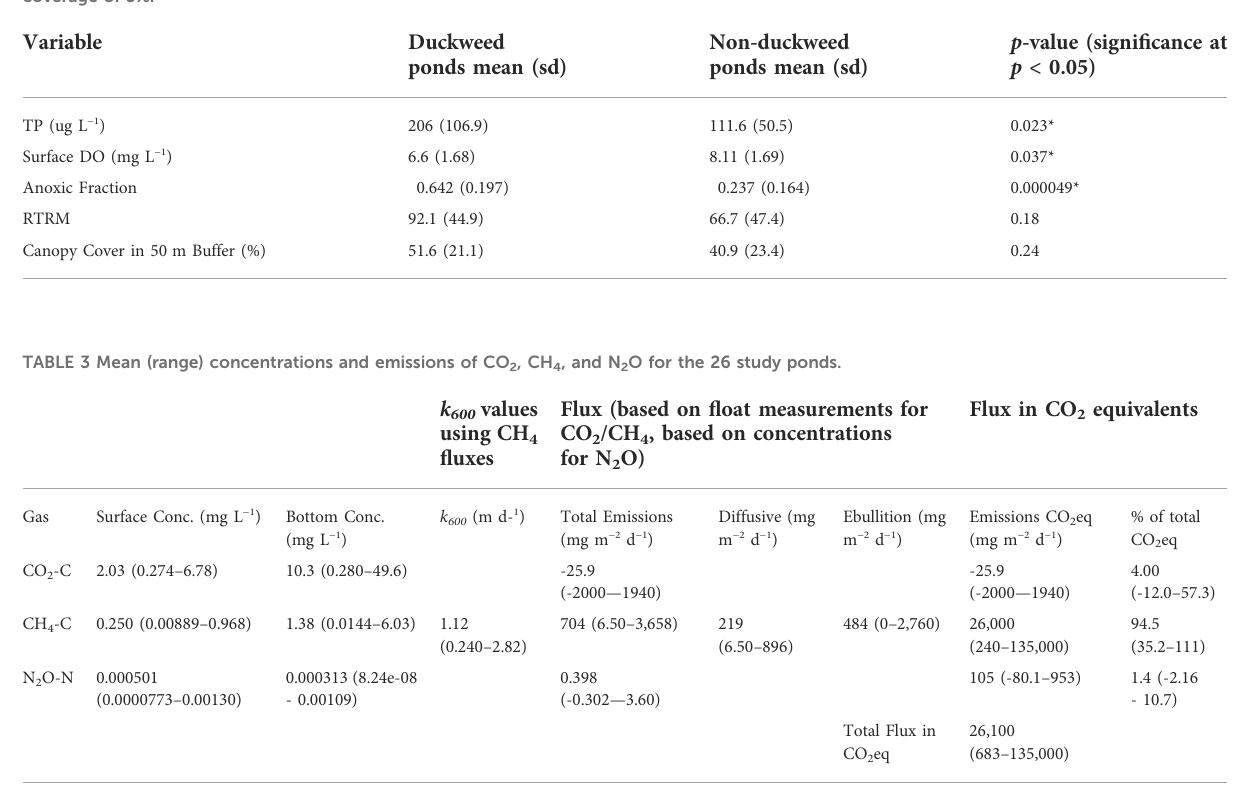
TABLE 2 Differences in environmental variables between duckweed ponds and non-duckweed ponds. Ponds were categorized as duckweed or non- duckweed by k -means clustering, with duckweed ponds having an average coverage of 96%, and non-duckweed ponds having an average coverage of 3%.